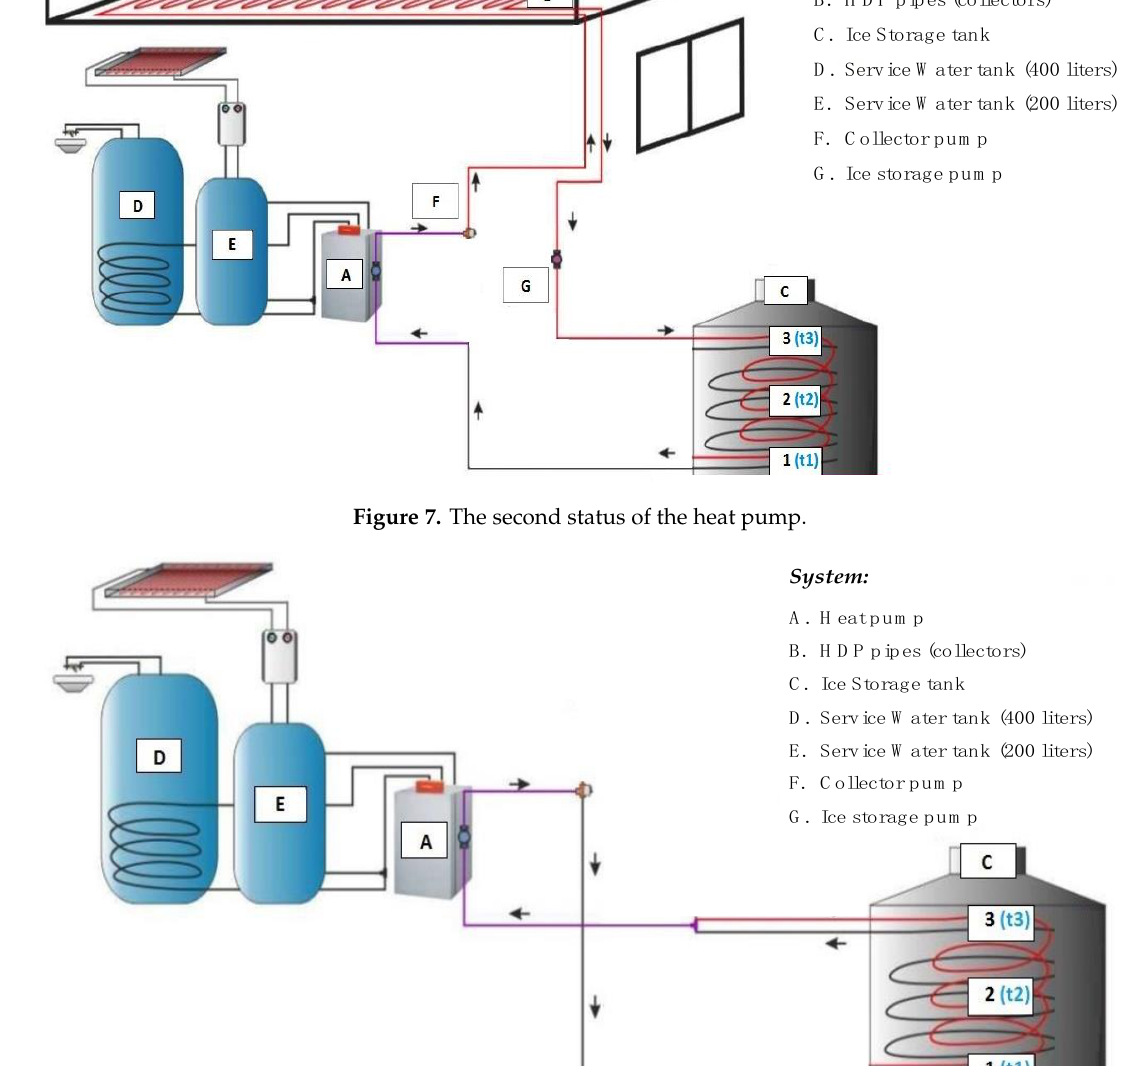
Figure 7. The second status of the heat pump.